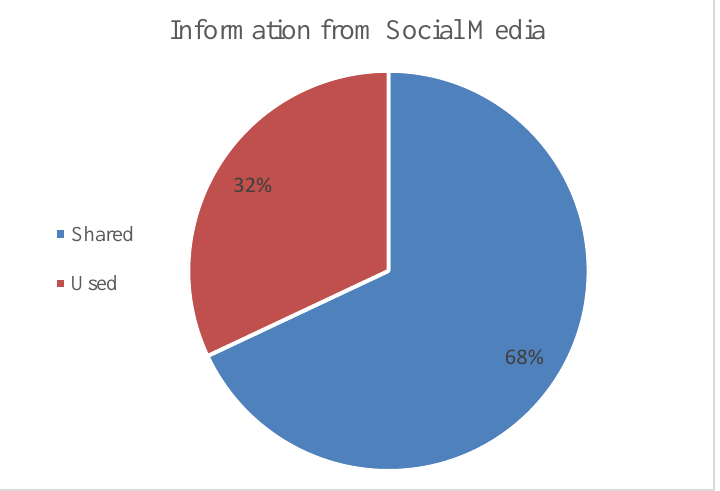
Figure 1. Those who shared versus those who actually used/acted on social media information.